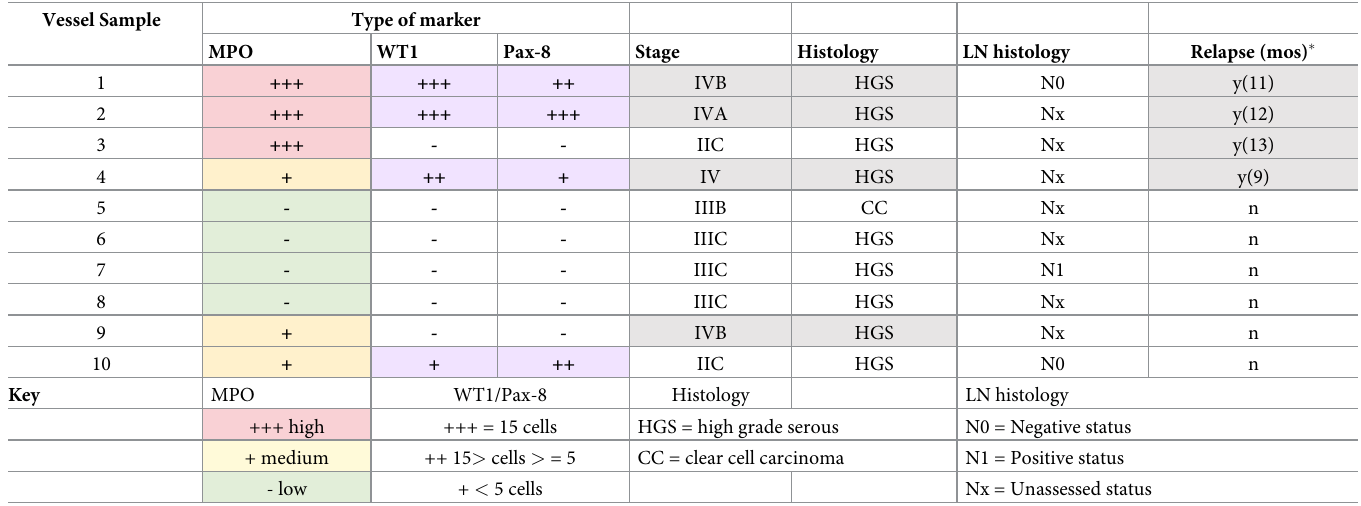
Sections of the LVs were stained with antibodies for the inflammatory marker myeloperoxidase (MPO), ovarian cancer markers Wilms-Tumour-1 (WT1) and Paired Box Gene 8 (Pax-8), and the lymphatic endothelial marker, Podoplanin (PDPN). � Mean time since surgery = 13.2 ± 3.6